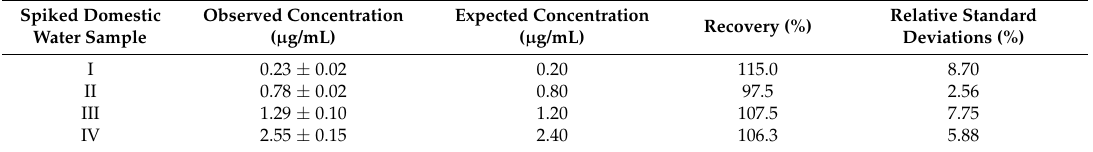
Table 2. Prediction of malathion concentration in spiked domestic water